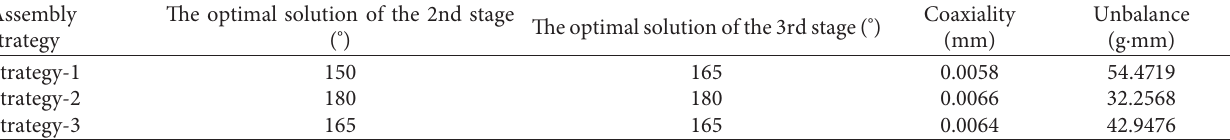
Table 4: The simulation results of the genetic optimization with screw holes.